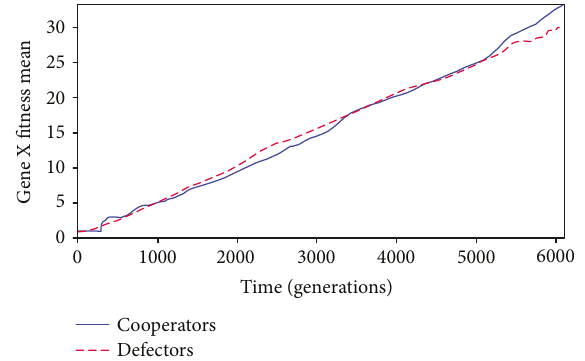
Figure 18: Relationship between invasion time of a silent cooperative gene and the length of its activation time. For every value of the activation time, the simulation has been run 100 times and the invasion time mean has been calculated. The vertical bars represent the standard deviation of the